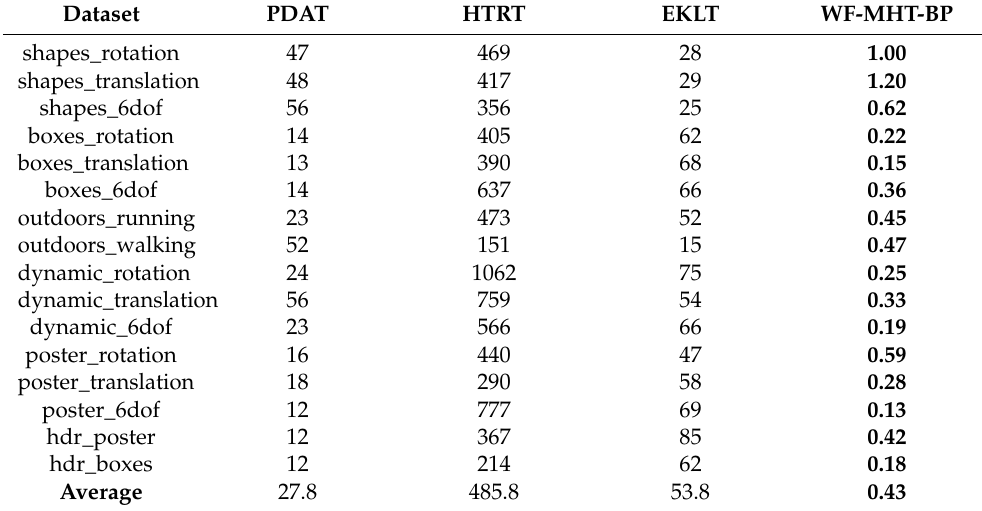
Table 3. The consumed time per tracked features of PDAT/HTRT/EKLT/WF-MHT-BP methods (unit: